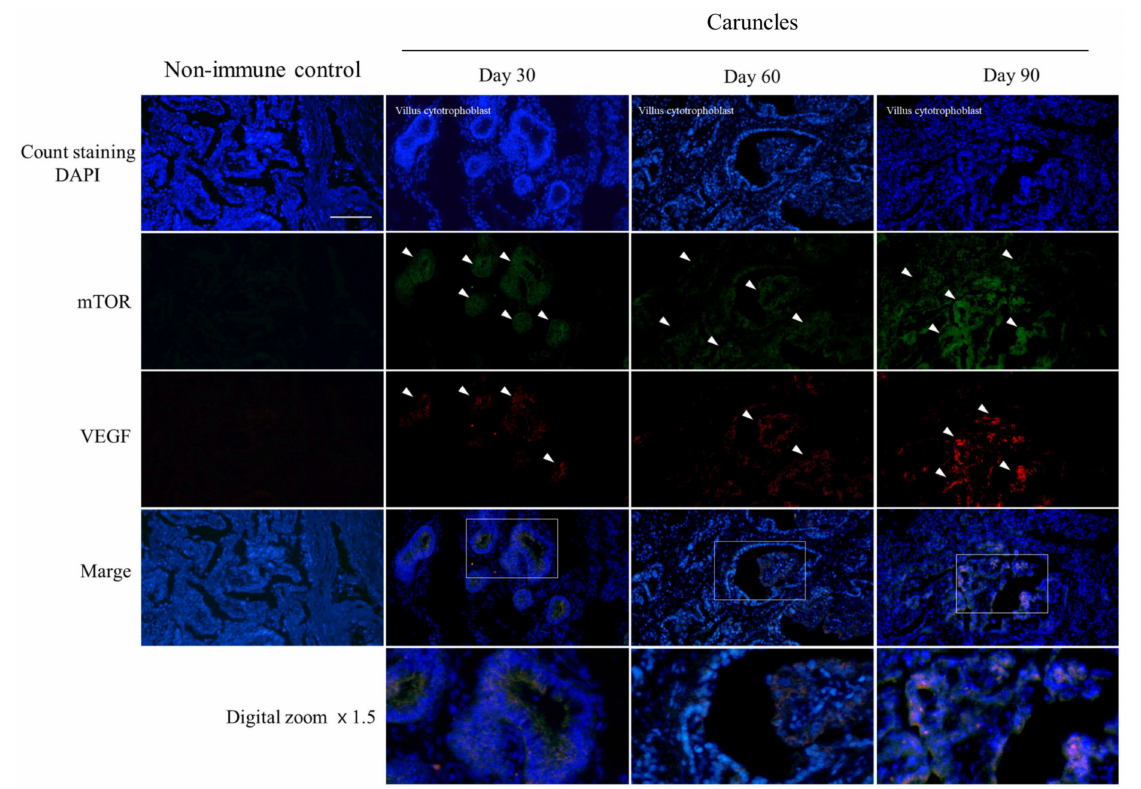
Figure 4. Immunofluorescence multicolor staining of mTOR and VEGF protein in caruncle tissue. Staining shows co-localization of detected protein with fetal villi and cytotrophoblast cells during early pregnancy caruncle tissue. Caruncle sections were stained with mTOR and VEGF antibodies in combination. mTOR was counterstained with Alexa Fluor 488 conjugated goat anti-mouse IgG (green). VEGF were counterstained with Alexa Fluor 594 conjugated goat anti-rabbit IgG (red). The nuclei were stained with Hoechst 33258 (blue). Overlays are shown in the down panels. Similar results were obtained in 3 separate experiments. White arrows indicate representative detection positions of the target protein. Scale bar=100 µ